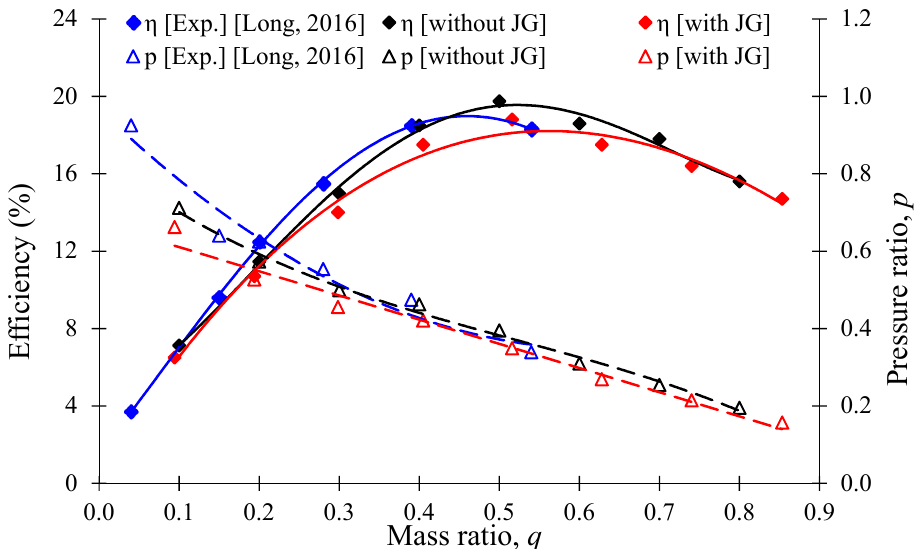
Figure 10. Comparison of performance curves between experimental [23] and CFD analysis of AJP model without and with J-Groove (JG).